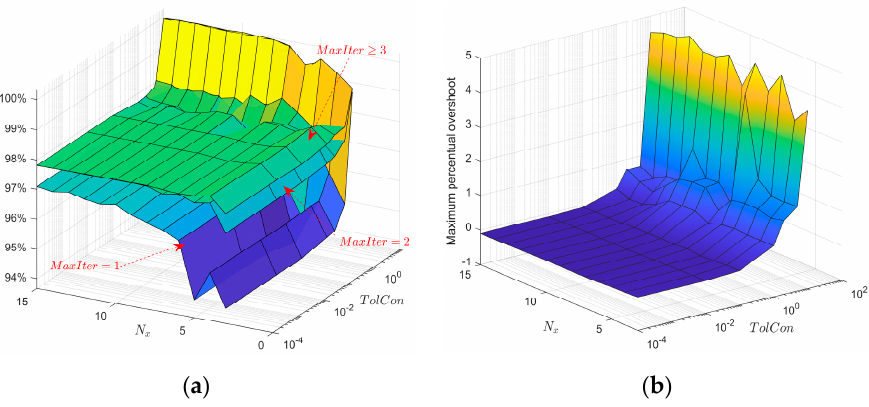
Figure 17. DoE with variable 𝑁 (cid:3051) , MaxIter and TolCon : ( a ) Produced energy in function of the varied parameters; ( b ) stress overshoot in function of the varied parameters.